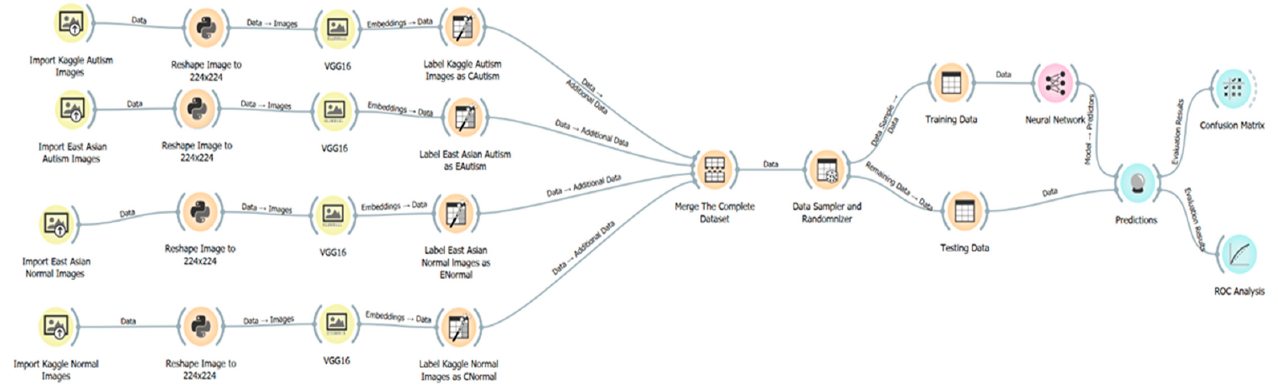
Figure 5. Pipeline architecture (Orange platform screen shot) with the four classification target classes described in Table 2. Table 2. Using four classification target classes with additional race information preceding the label.